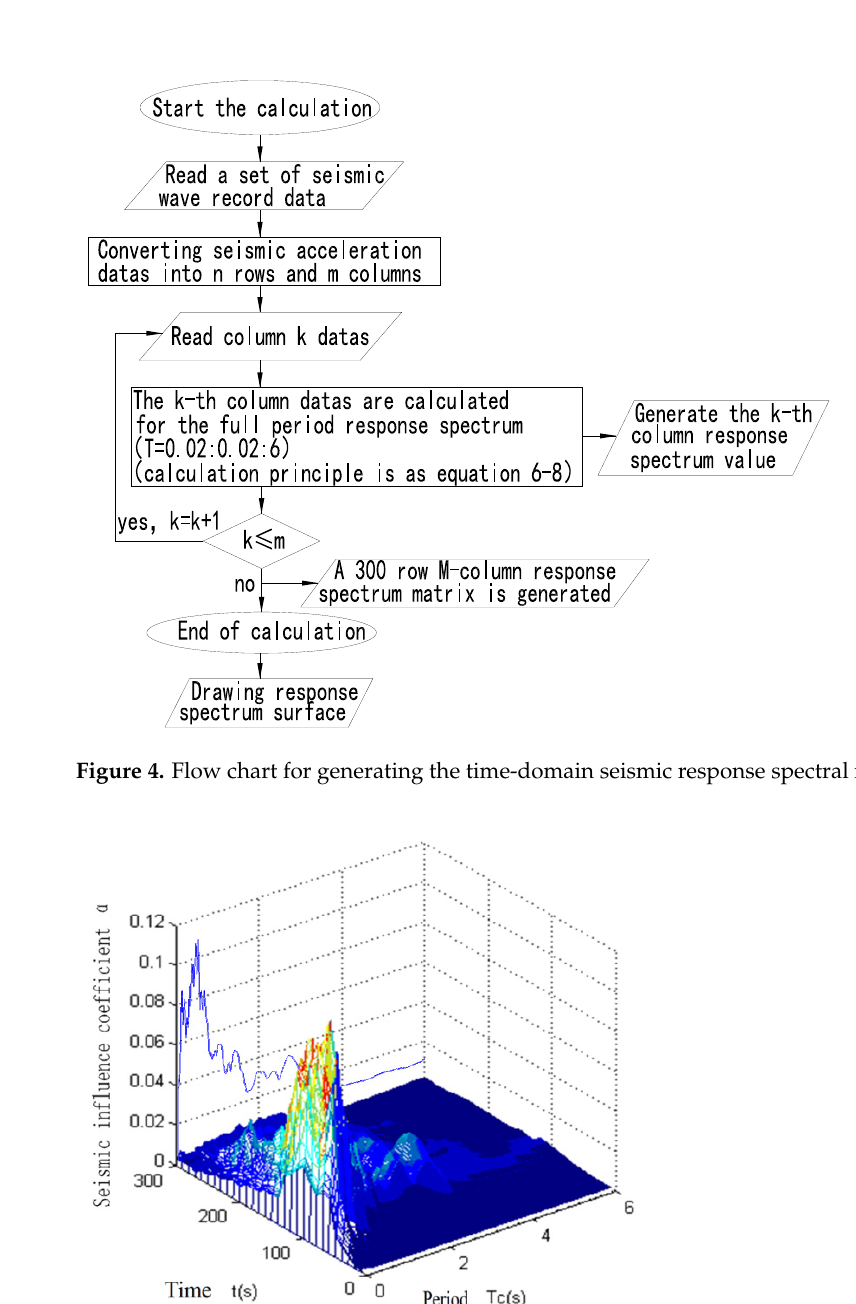
Figure 5. Time-domain curved surface of the seismic influence coefficient of absolute acceleration (with a time interval of 10 s).